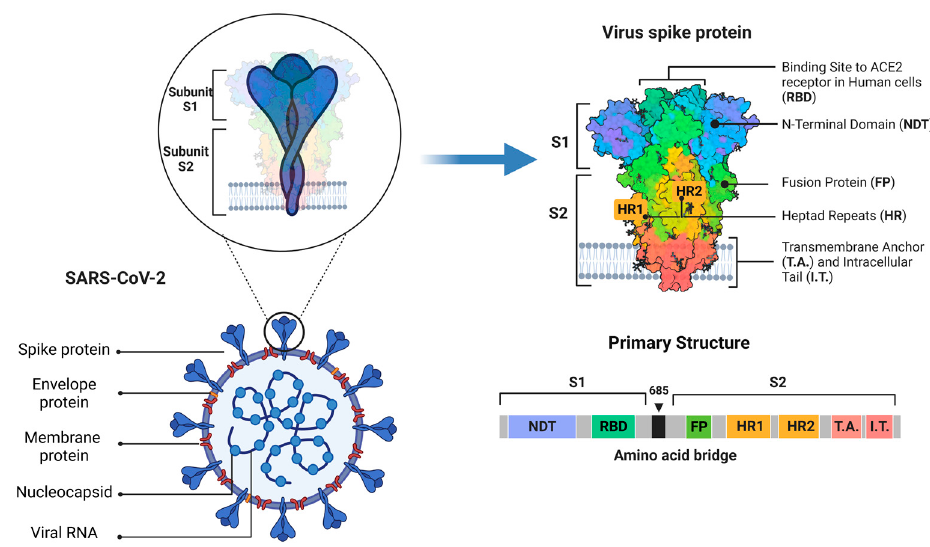
Figure 1. Overall structure of SARS-CoV-2 virus and tridimensional and primary structures of the spike protein.